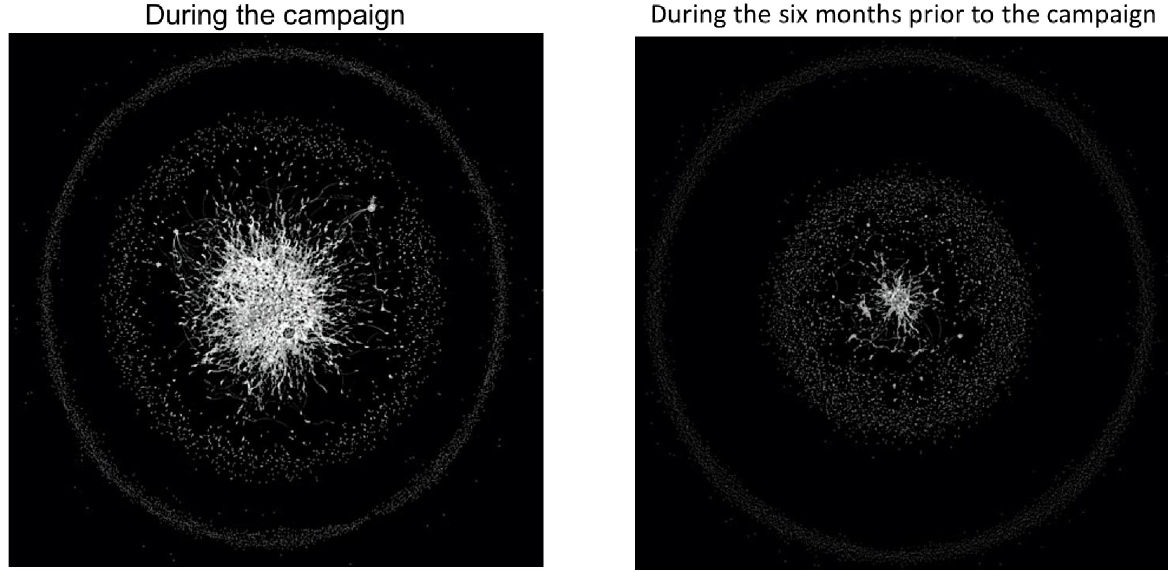
Fig 1. Social network maps. Each dot (node) represent a unique individual that tweeted to the network and the lines (edges) between the nodes reflect exchanged tweets (mentions and retweets). During the campaign, n = 29,958; Six-month data, n = 10,694.